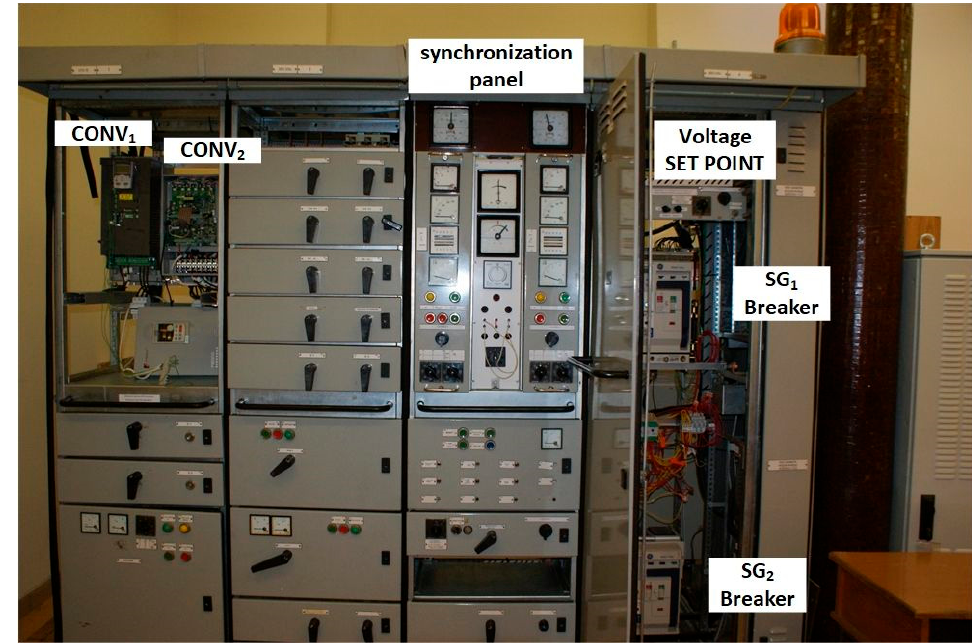
Figure 16. Laboratory stand: main switchboard; CONV 1 and CONV 2 —converters supplying the electric motors (CM 1 , CM 2 ).